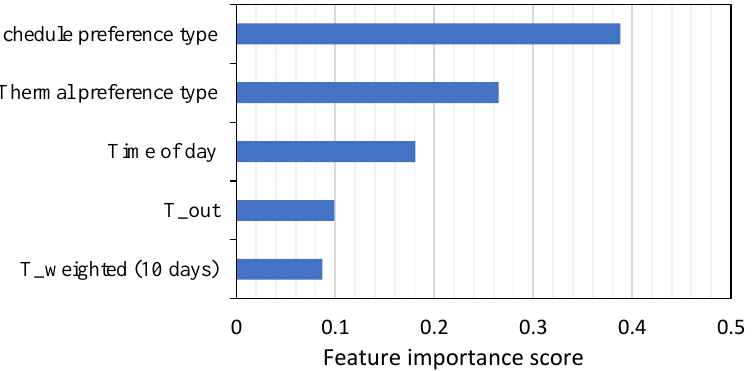
Figure 13. ROC curve of the prediction model.